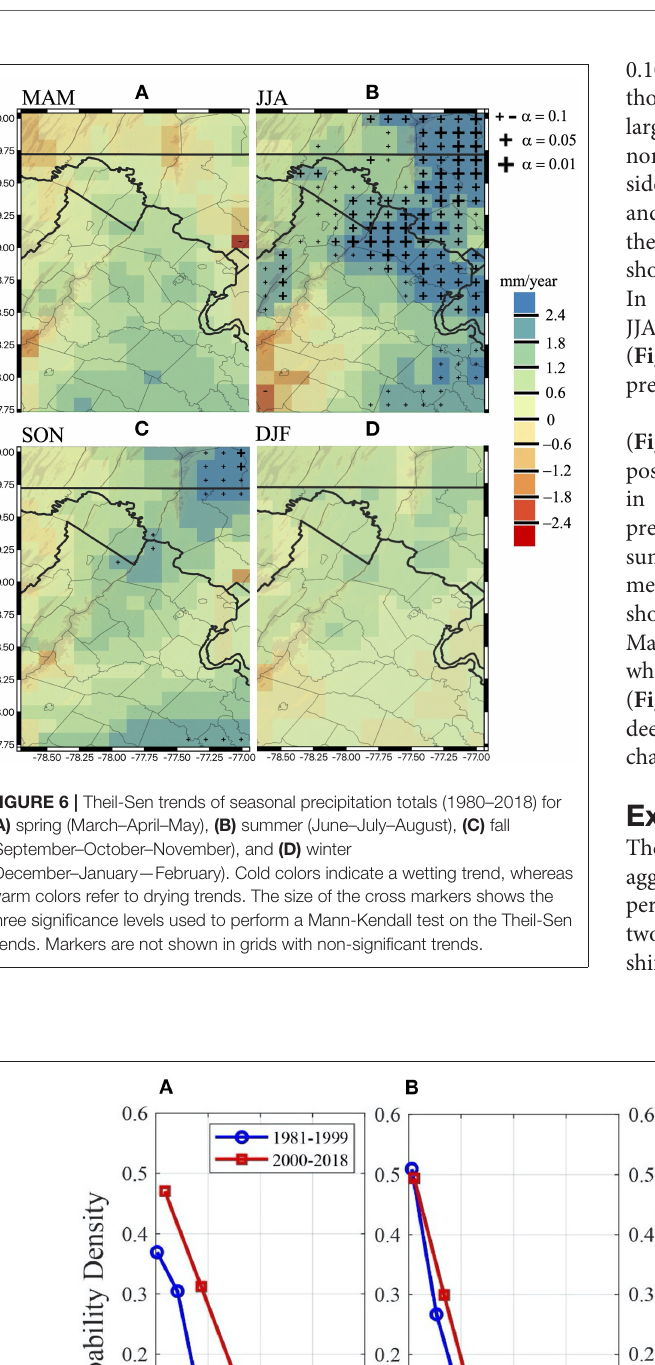
FIGURE 7 | Probability density functions of the top 5% daily precipitation during (A) spring, (B) summer, (C) fall, and (D) winter across the entire study area. The time series is broken into two periods: 1981–1999 (blue) and 2000–2018 (red).